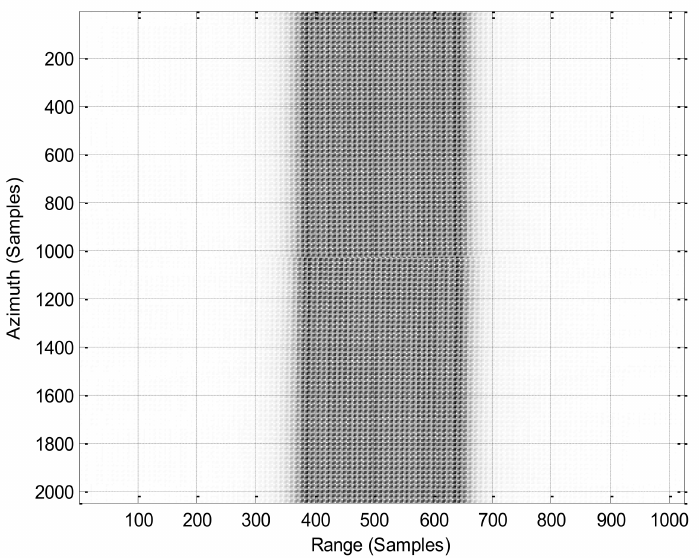
Figure 6. SAR raw data transformed by the proposed processor into the frequency